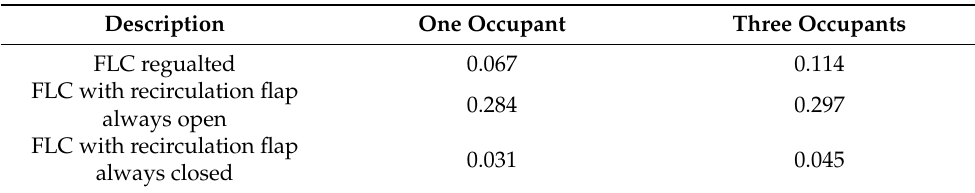
Table 5. Average area under the curve of the product of the HVAC on time and its corresponding mass flow rate (kg/s) in simulations with different